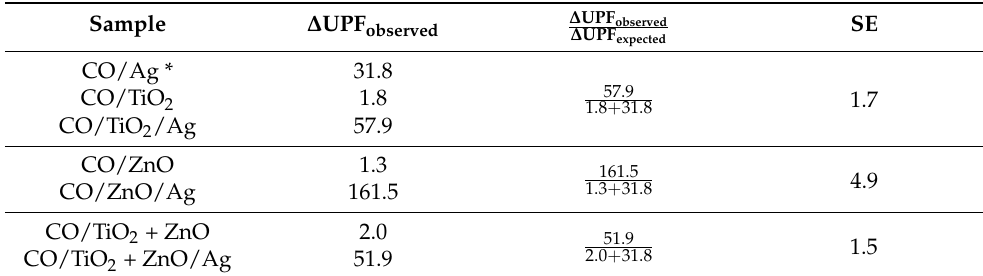
Table 4. Calculated ∆ UPF observed and the synergistic effect, SE, between the components in the 25-times-washed composite coatings.